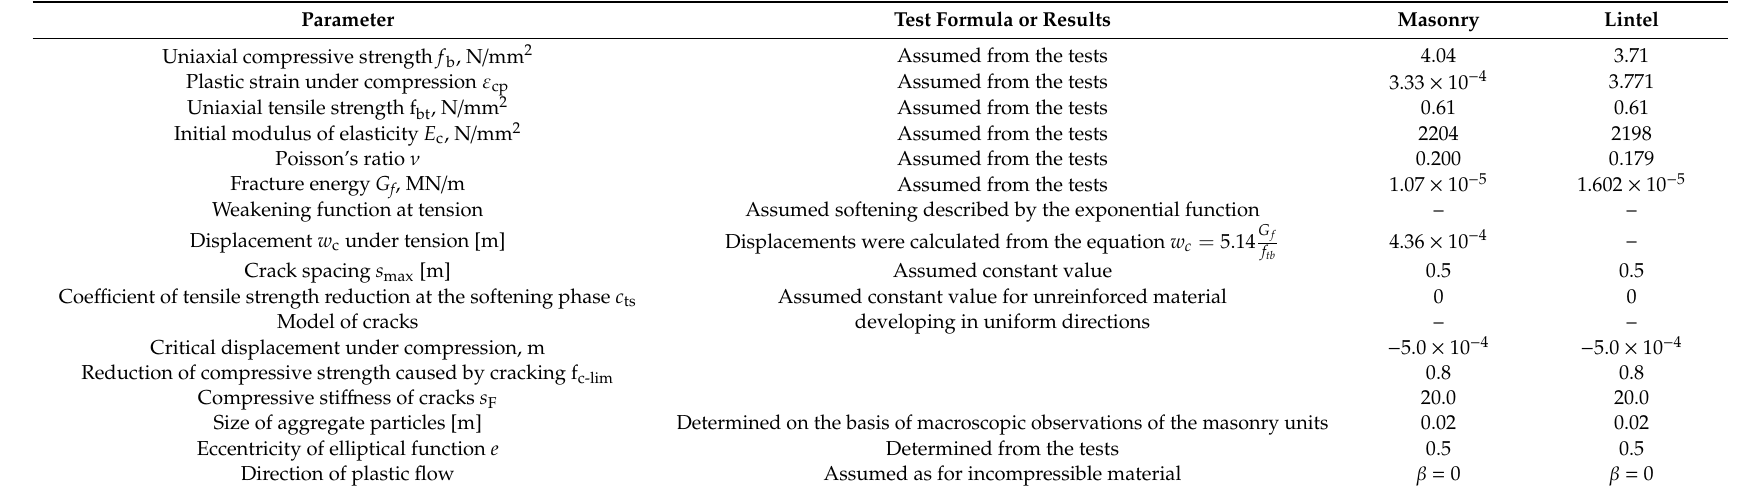
Table 4. Parameters of the plastic and elastic model used in